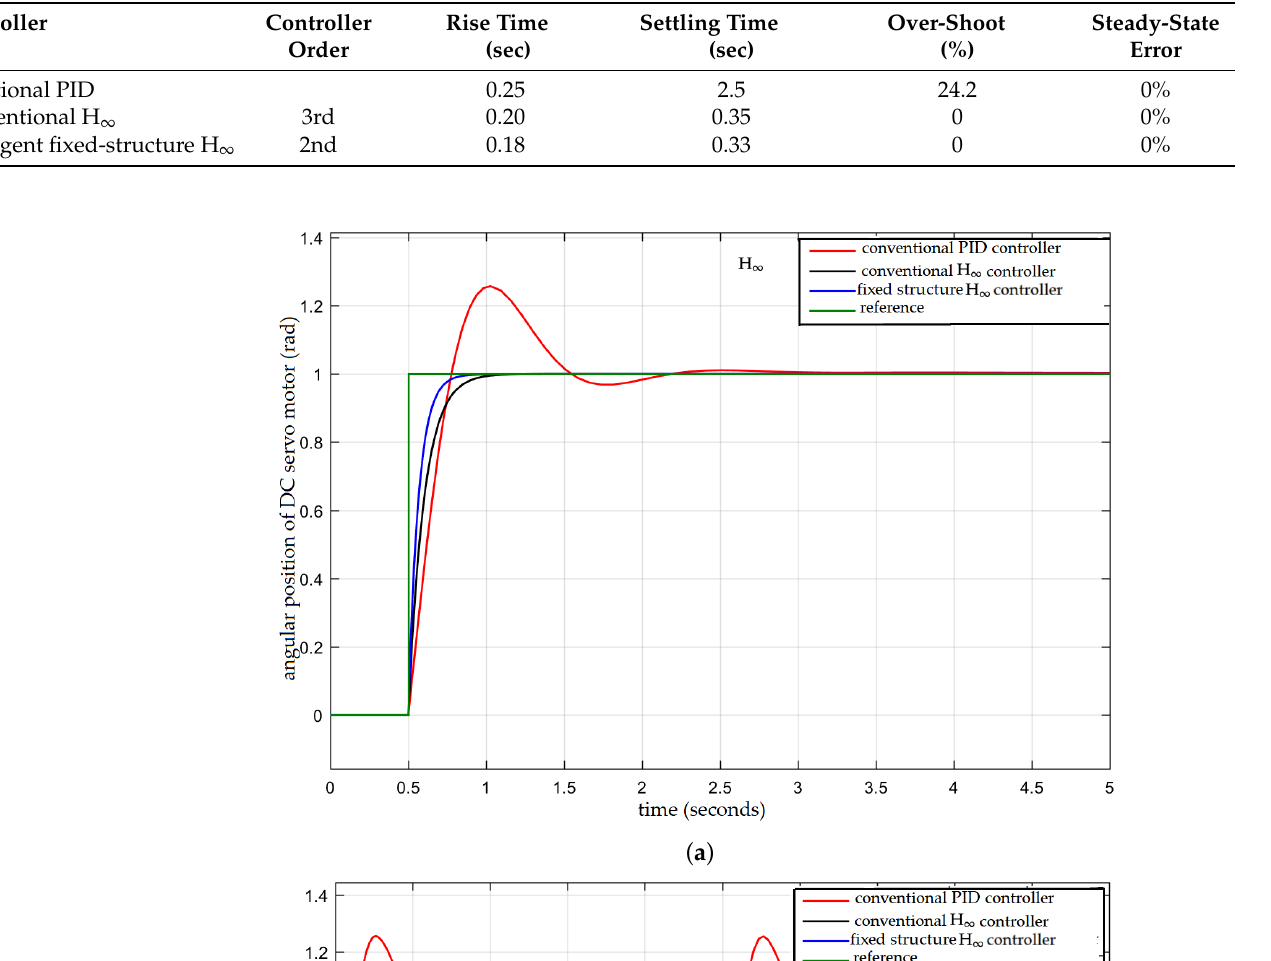
Table 9. The performance comparison between proposed and conventional controllers.